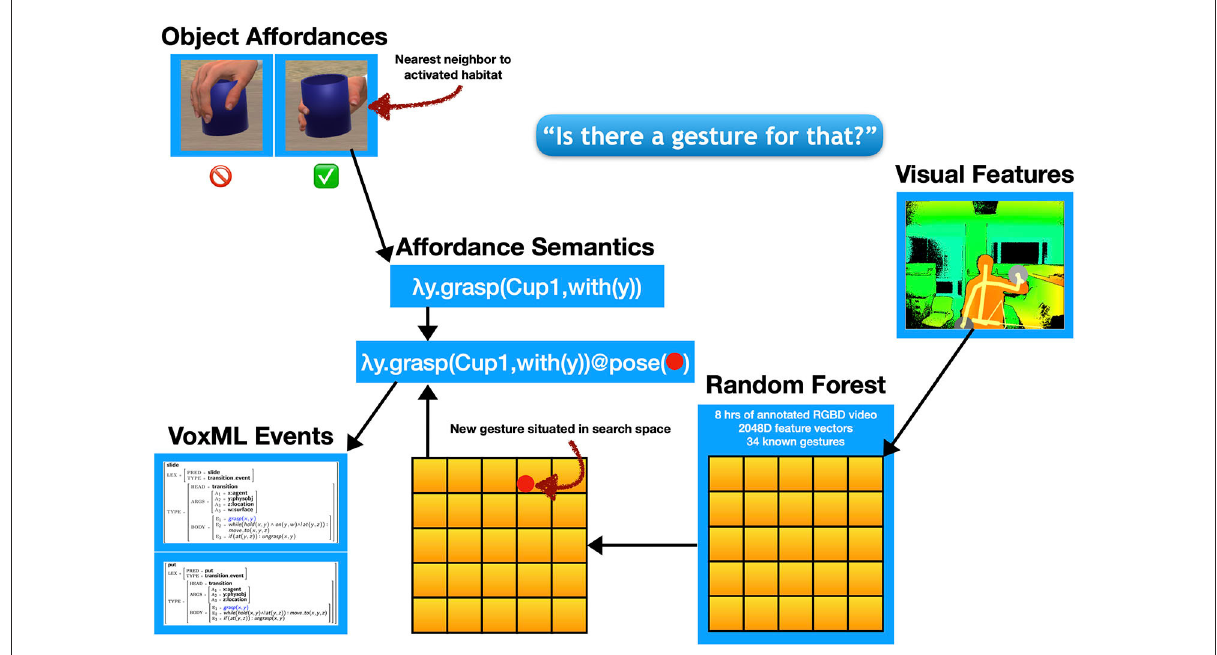
FIGURE9 Neurosymbolic pipeline for learning interactions with object affordances. The new visual features are situated in the feature space of a deep convolutional neural model and assigned a new label.